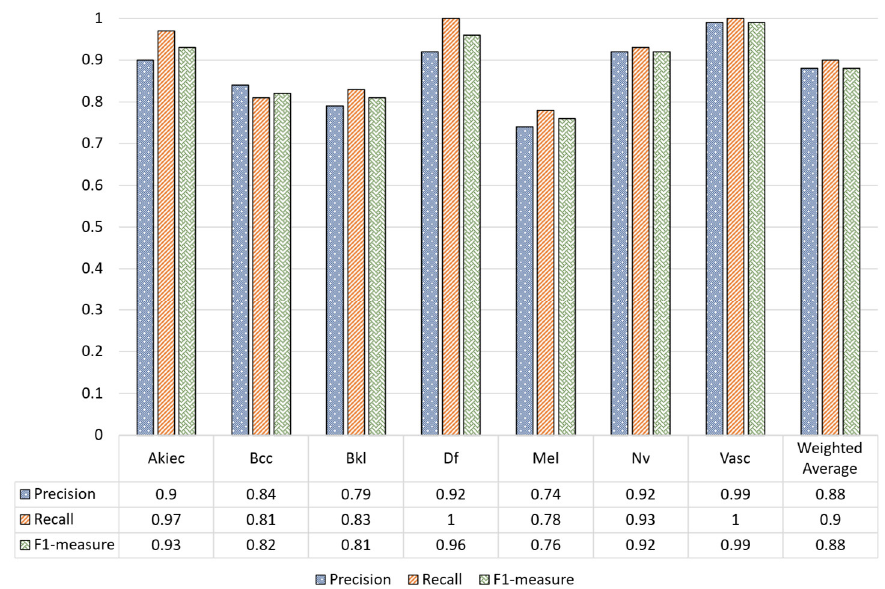
Figure 5. Classification report of our model used without the preprocessing stage.